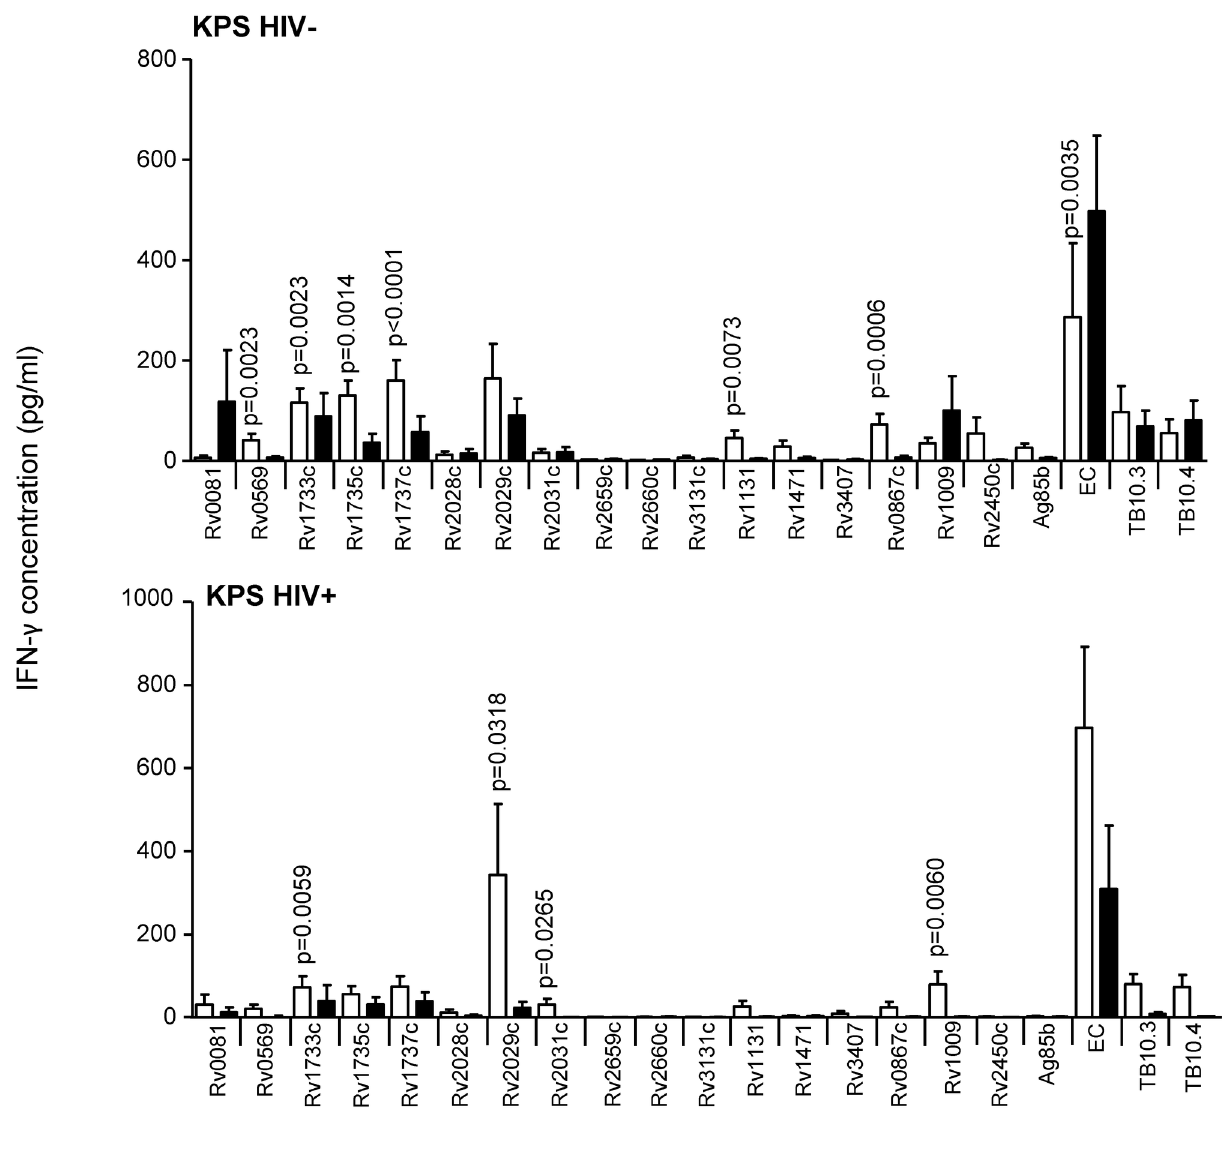
Figure 4. IFN-γ secretion in response to secreted, latent, and reactivation Mtb antigens in active TB and LTBI subjects, from Malawi. IFN-γ ELISA was performed on supernatants collected after 7-day antigen stimulation of diluted blood from TB cases (black) and TST+ (LTBI) controls (white) from KPS (Malawi). Line indicates median, whiskers indicate 5–95% range and dots indicate outliers. Data were analysed by Mann-Whitney U-test for HIV – and/or HIV + subjects. Significant differences are indicated.